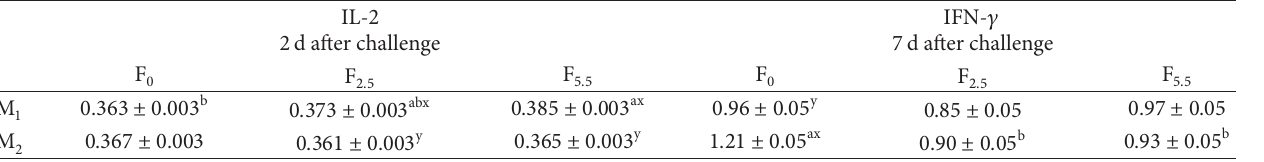
IFN- 𝛾 7 d after challenge